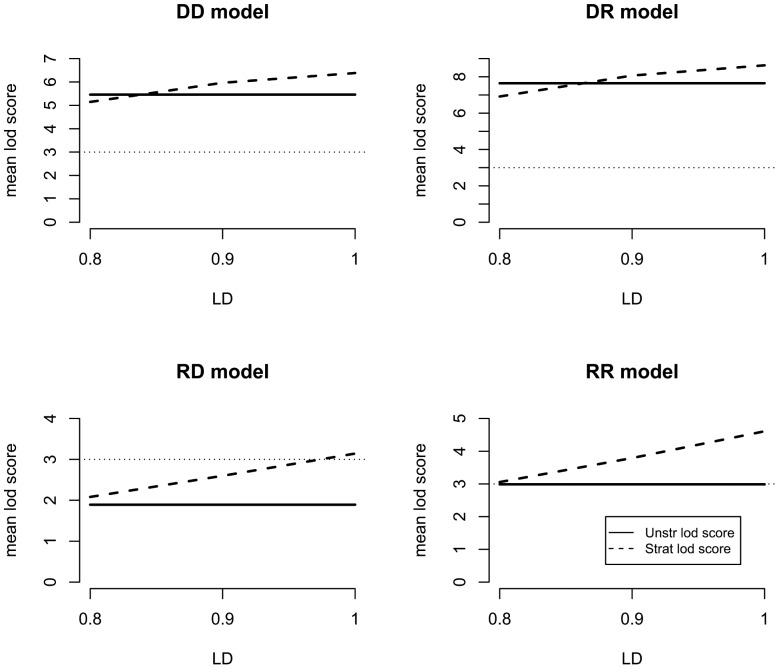
Lod score values varying the D' value between marker 4 and disease locus A.Unstratified lod score is represented by solid line and stratified lod score by dashed line. Horizontal dotted line identifies the threshold for significant evidence of linkage.